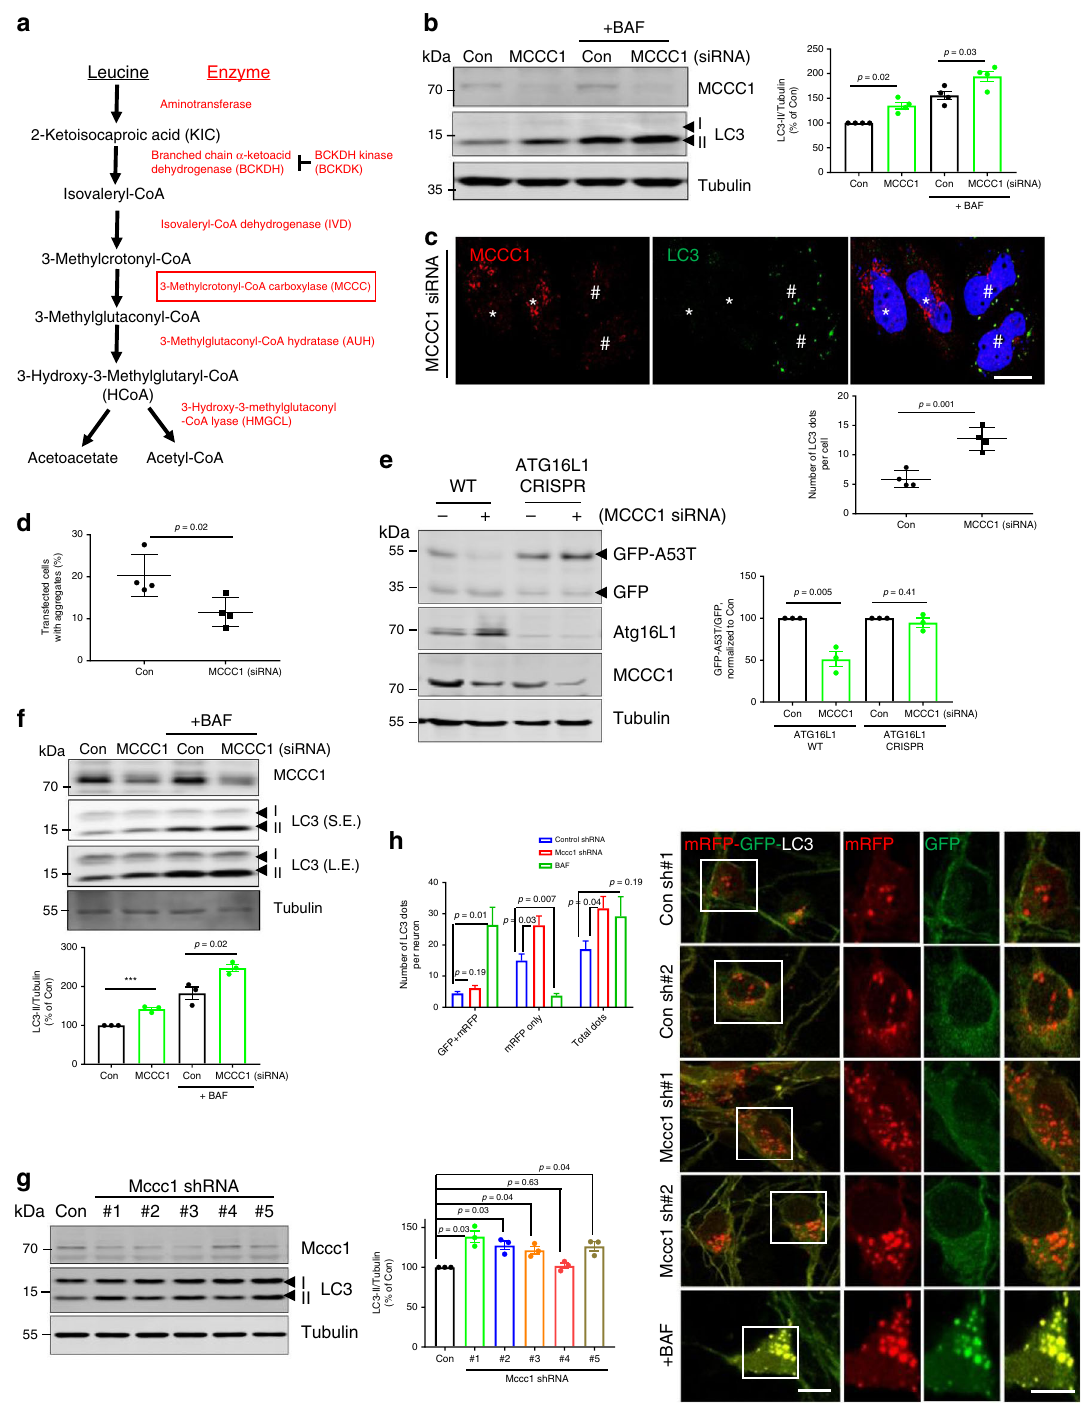
Fig. 4a) — phosphorylation of ULK1, a key autophagy protein,